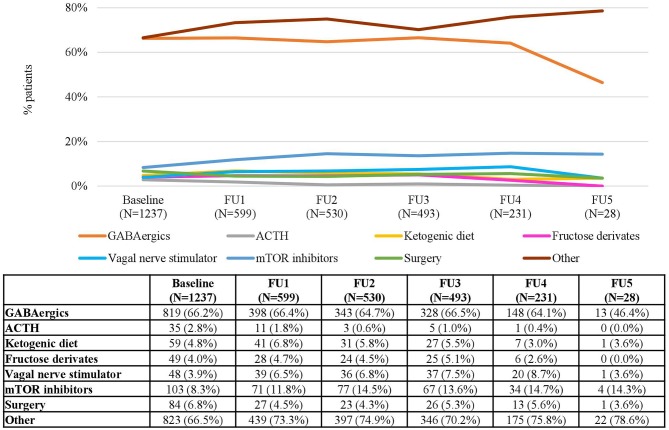
Treatments for Focal Seizures in each Follow-up Visit. Patients may receive more than one treatment. Baseline data refers to patients who “ever had” the manifestation.